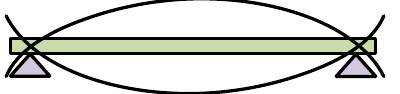
Figure 3. Fixed mode of the elastic steel plate.